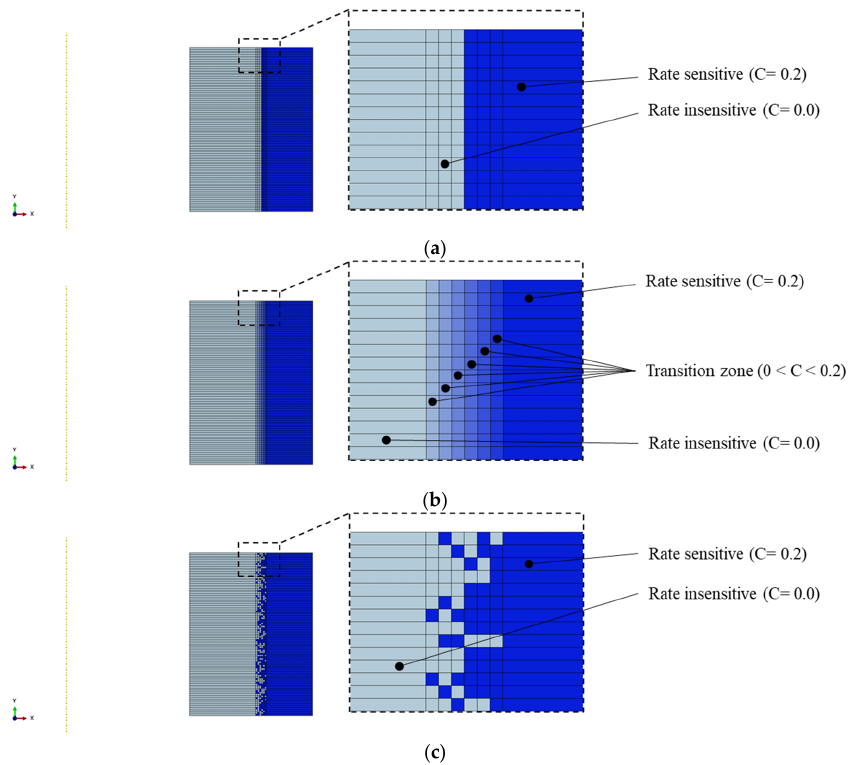
Figure 16. Different topologies of materials at the bonding surface of rate-sensitive and insensitive material: ( a ) non-layered, ( b ) ordered layers and ( c ) noise diffusion.